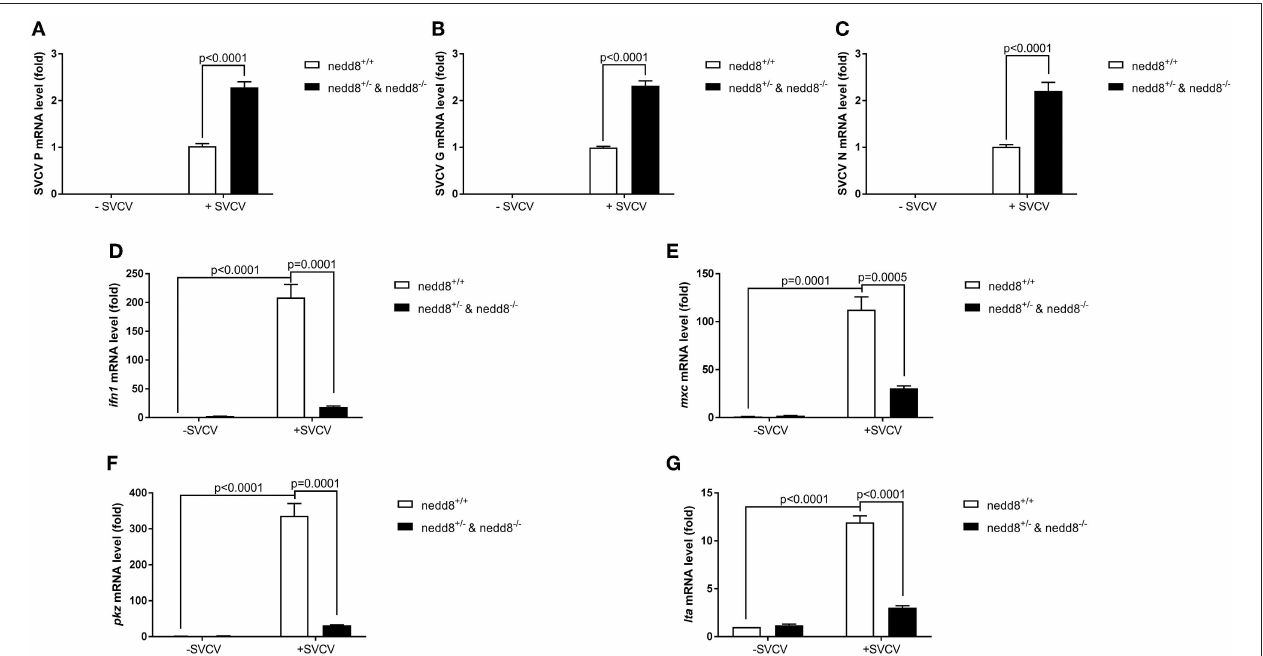
FIGURE 7 | Disruption of nedd8 in zebrafish after SVCV infection increases viral replication and downregulates key antiviral genes. (A–C) Viral replication increased in nedd8 -disrupted zebrafish larvae ( nedd8 + / − & nedd8 − / − ) larvae after SVCV infection, as compared to WT larvae. (D–G) The expression levels of key antiviral genes after SVCV infection were lower in nedd8 -disrupted zebrafish larvae than in WT larvae. At 3 dpf, we added viruses (2 × 10 8 TCID 50 /ml) into the water containing zebrafish larvae. After incubation for 24h, we extracted total RNA from all larvae and performed qPCR assays to detect the expression levels of ifn1 (D) , mxc (E) , and pkz (F) , and ita (G) . Data are shown as mean ± SEM of three independent experiments, each performed in triplicate; the statistical analysis was performed using GraphPad Prism 5 (unpaired t